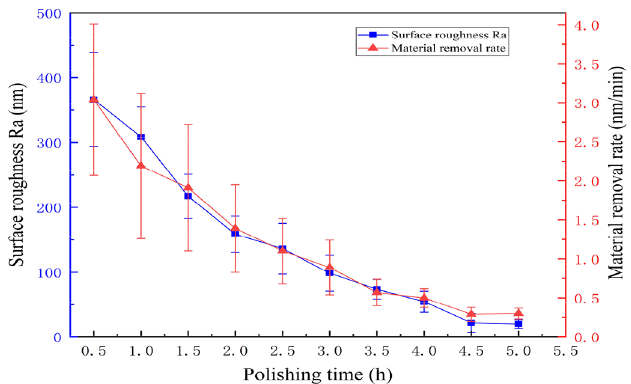
Fig. 8. Surface roughness ( R a ) and material-removal rate under different polishing